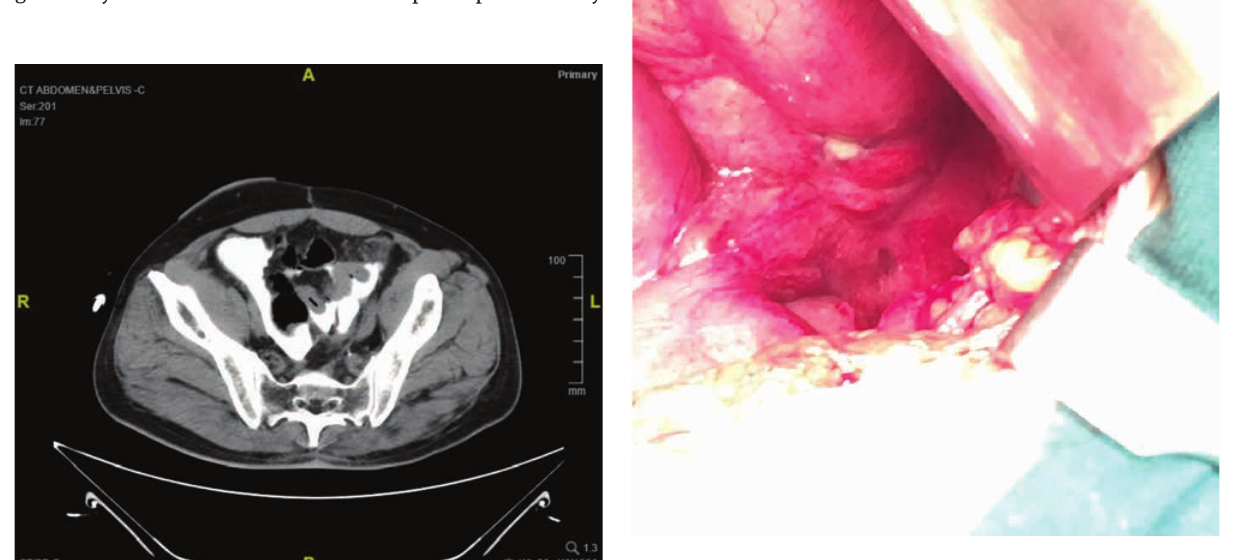
Figure 5: (Case 2) CT abdomen done eight hours after the distal loopogram, showed contrast pooling at the pelvis .